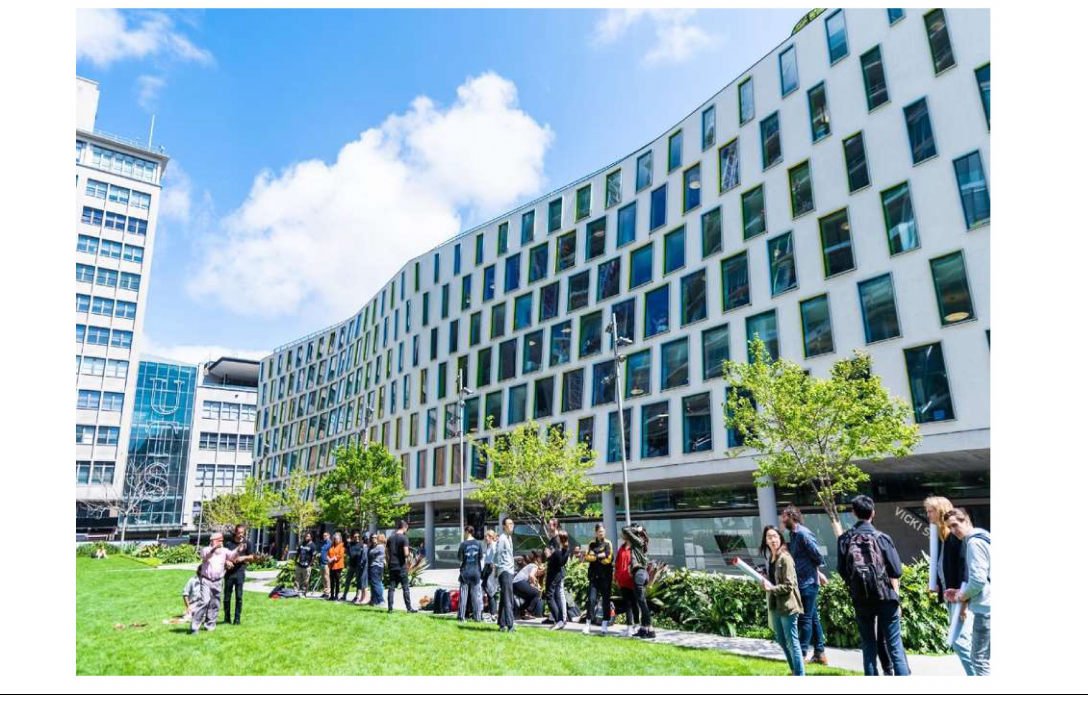
Figure 2. Uncle Max and his family preparing for the Smoking Ceremony on Gadigal Land, UTS Alumni Green in November 2018 (Source: photograph by Kwa Nguyen)